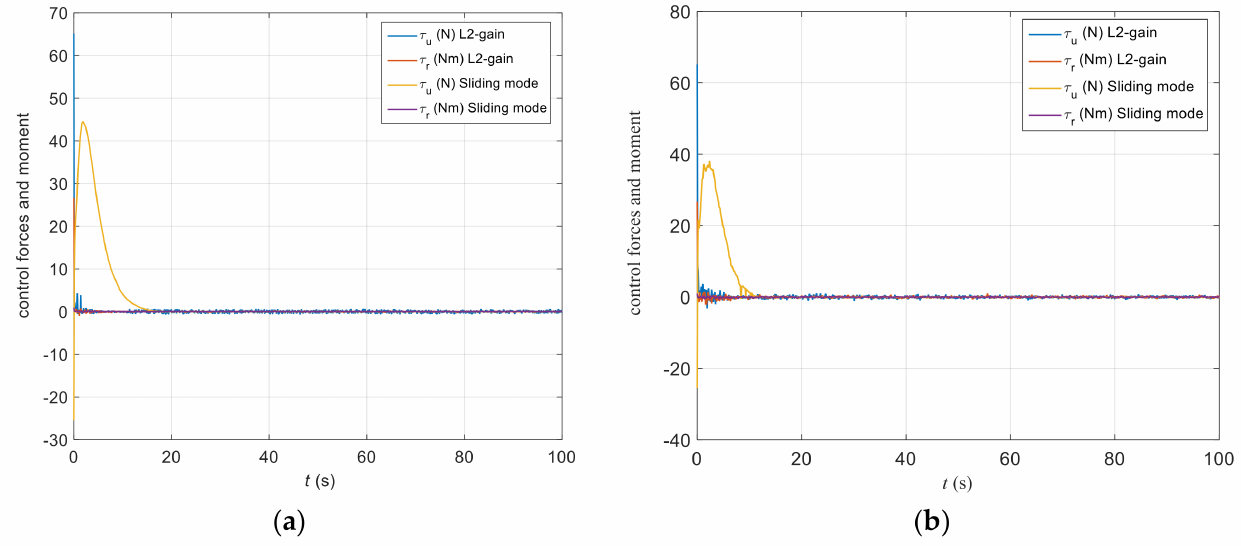
Figure 8. Control forces and moments on the surface ship. ( a ) Disturbances at the level of 0.5*randn; ( b ) disturbances at the level of 5*randn.